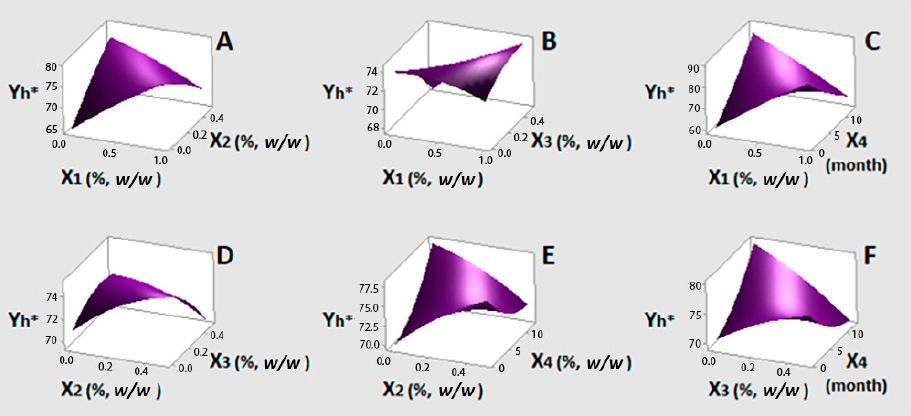
Figure 4. A-F three-dimensional surface plots for color parameter h* (Y h* ) as a function of oregano (X 1 %, w/w ), lemon balm (X 2 %, w/w ), bay laurel (X 3 %, w/w ) EOs contents and time (X 4 , month). In all cases, the rest factors were kept constant at their middle levels (0.5%, 0.25% and 0.25% w/w and seven months, respectively).